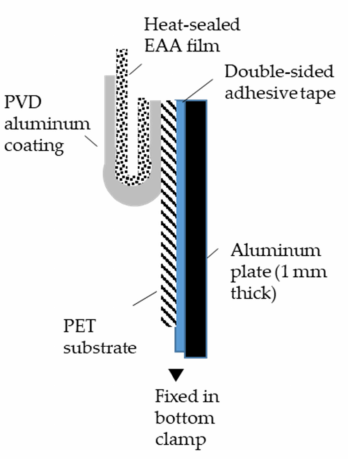
Figure 1. Schematic representation of the 180 ◦ EAA peel